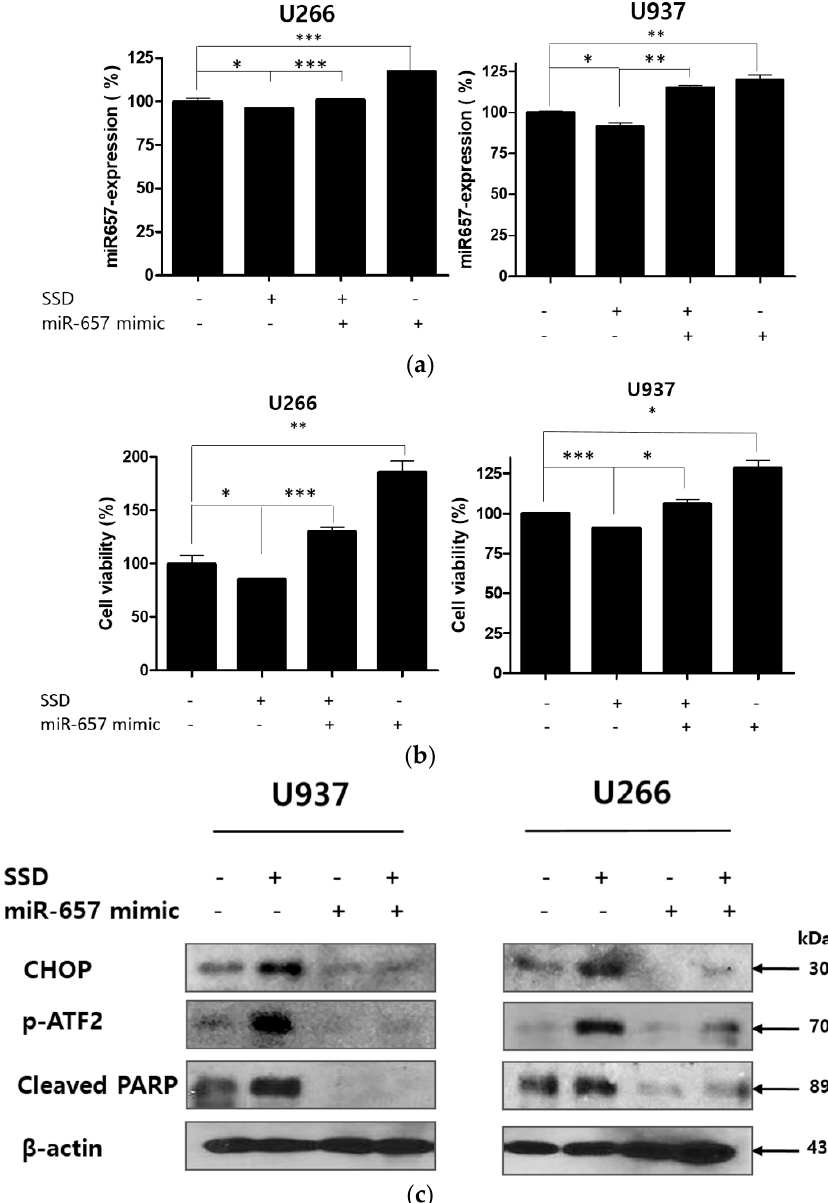
Figure 8. Effect of miR-657 in SSD-induced apoptosis in U266 and U937 cells. Cells were transfected with miR-657 mimic for 48 h (sample number n = 4). ( a ) To determine the expression level of miR-657, qRT-PCR for miR-657 expression was performed after 24 h of SSD (20 µ g/mL) treatment with or without miR-657 transfection. ( b ) Cell viability was determined by an EZ-CYTOX cell viability assay kit (20 µ g/mL of SSD exposure for 24 h). ( c ) Cells were transfected with miR-657 mimic and treated with 20 µ g/mL of SSD for 24 h. Western blot analysis was implemented for CHOP, p -ATF2, and cleaved PARP. Values represent the means of three experiments ± SD; * p < 0.05; ** p < 0.01; *** p < 0.001 between the two